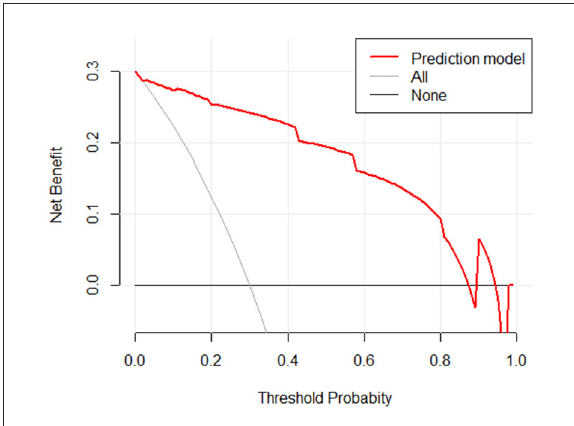
FIGURE10 Clinical decision curve for the risk of sepsis in infected patients. (X: probability with value, Y: net benefit, black line: hypothesis of no sepsis in all patients, gray line: hypothesis of sepsis in all